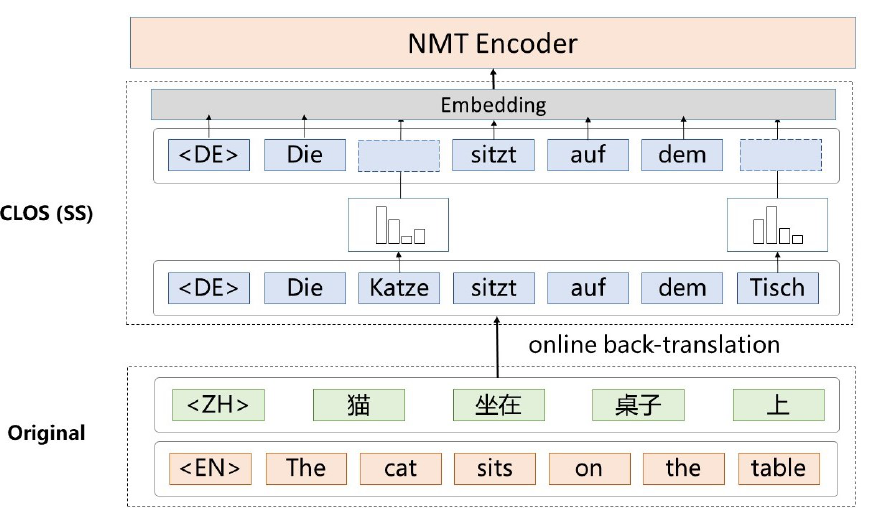
Figure 2. Cross-lingual online substitution by randomly replacing words with their synonyms from other languages. Soft substitution replaces the embedding of one word by a weighted combination of multiple semantically similar